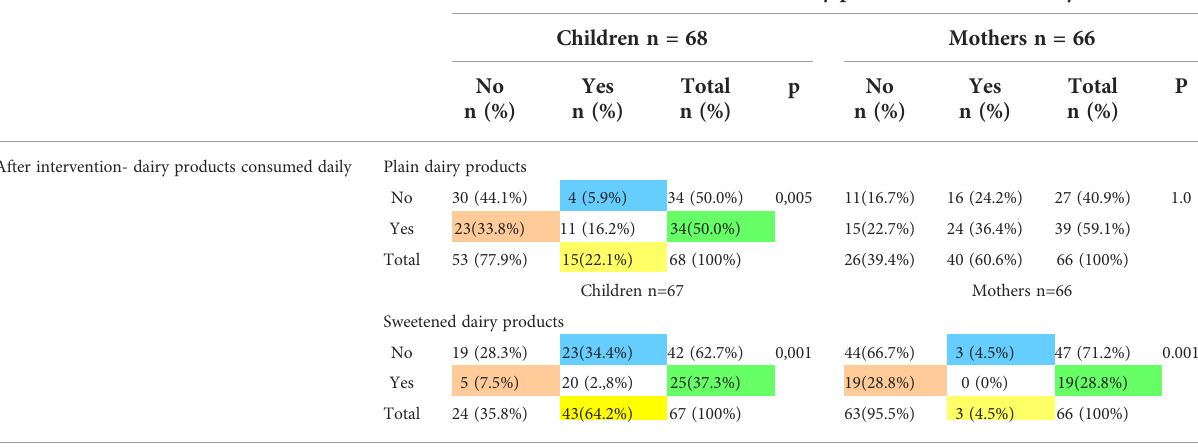
TABLE 5 Effect of one-year dietary intervention on consumption of selected dairy products consumed by studied children and their mothers. Assesed habit Before intervention – dairy products consumed daily